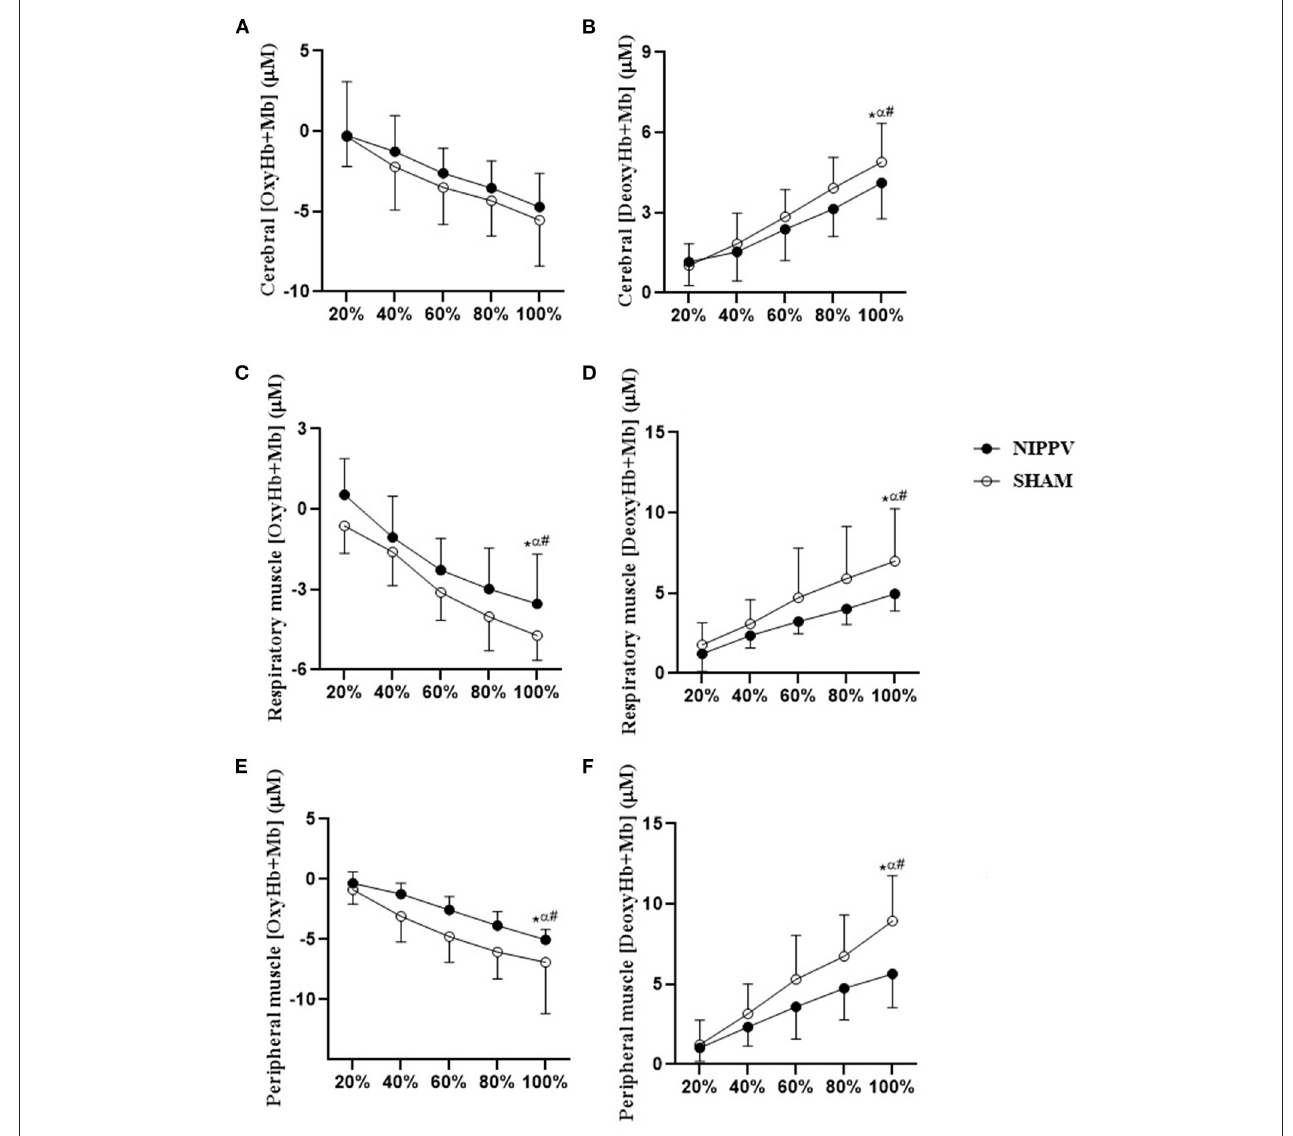
FIGURE 4 | Comparative analysis of the effects of NIPPV (closed symbols) and SHAM ventilation (open symbols) on Cox, respiratory, and peripheral muscle oxygenation. During high-intensity exercise ( N = 14). (A) (OxyHb + Mb) cerebral p interaction : 0.87; (B) (OxyHb + Mb) peripheral muscle (vastus lateralis muscle) p interaction : 0.10; (C) (OxyHb + Mb) respiratory muscle (intercostal muscle) p interaction : 0.79; (D) (DeoxyHb + Mb) cerebral p interaction : 0.03; (E) (DeoxyHb + Mb) peripheral muscle (right vastus lateralis muscle) p interaction : 0.79; (F) (DeoxyHb + Mb) respiratory muscle (intercostal muscle) p interaction < 0.01. * p < 0.05